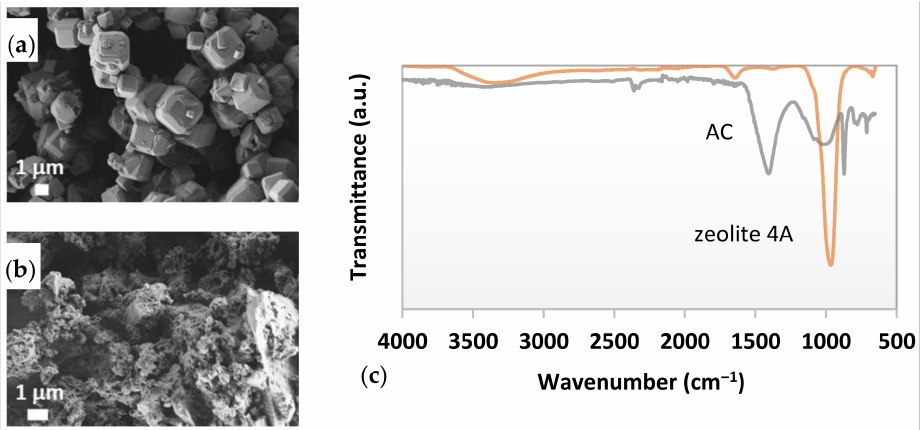
Figure 4. SEM images of: ( a ) 4A; ( b ) AC; and ( c ) FTIR spectra of the selected